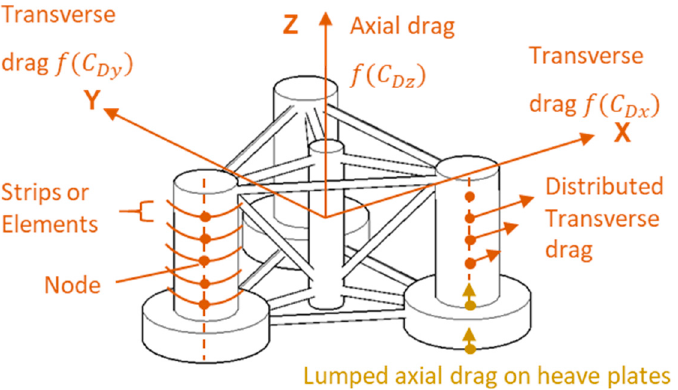
Figure 2. Strip-wise discretization of a typical submerged cylindrical body for Morison drag term